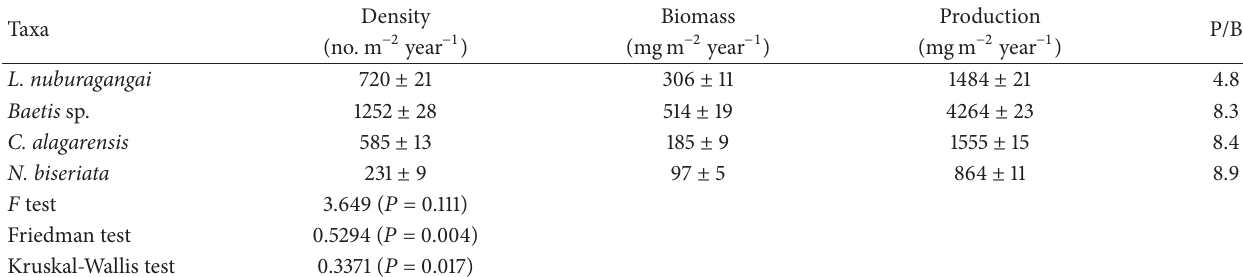
Table 4: Secondary production estimates (mean ± SE) for the four functional taxa using the size frequency